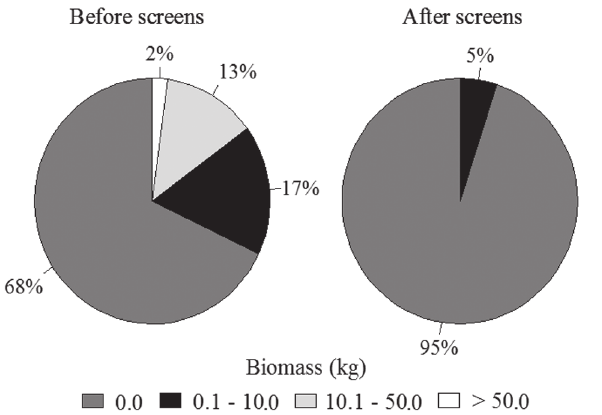
Fig. 5. Annual mean plus one standard error of dead/moribund fish biomass per turbine stop/startup before and after the use of fish